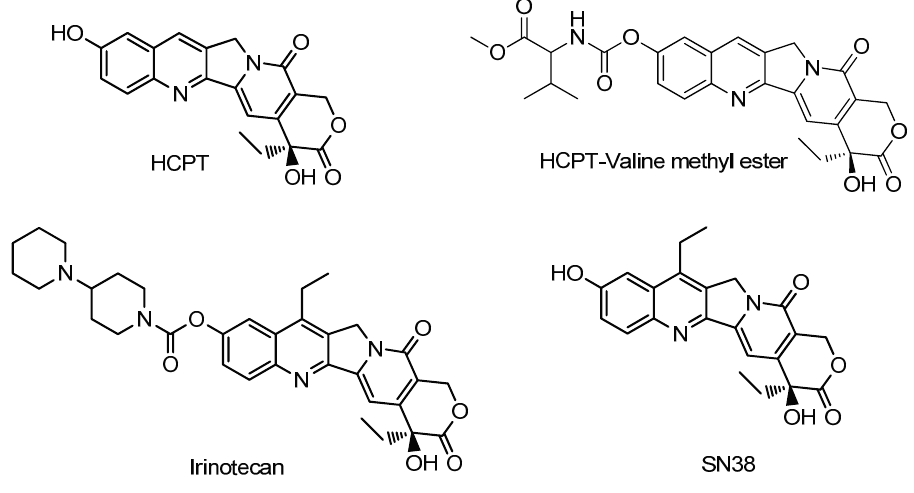
Figure 1. Structures of HCPT, HCPT-valine methyl ester, irinotecan and